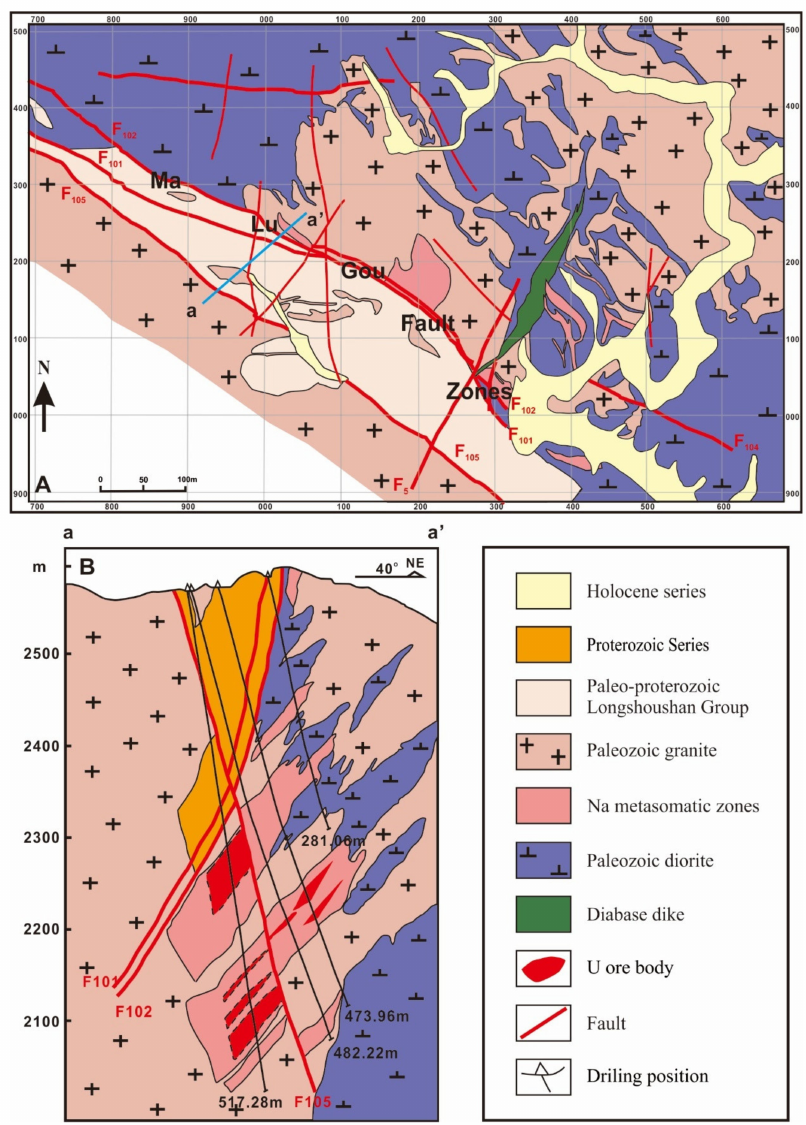
Figure 2. ( A ) A geological map of the area around the Jiling uranium deposit (modified after [39]). ( B ) A cross-section of the Jiling uranium deposit (modified after